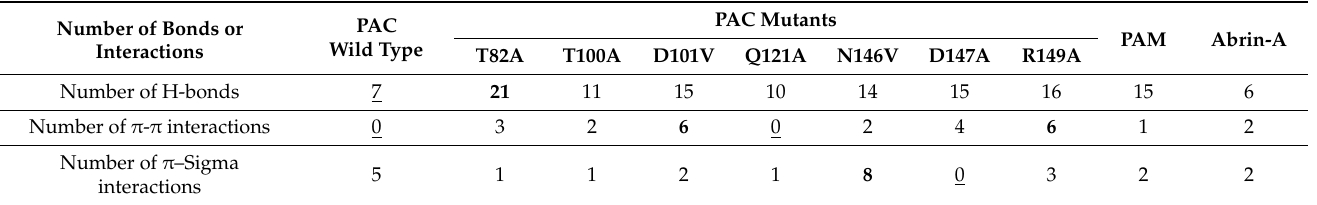
Table 4. Molecular docking analysis of mutants interacting with CGAGAG. Bold and underlined values represent the most and the least number of bonds or interactions, respectively.